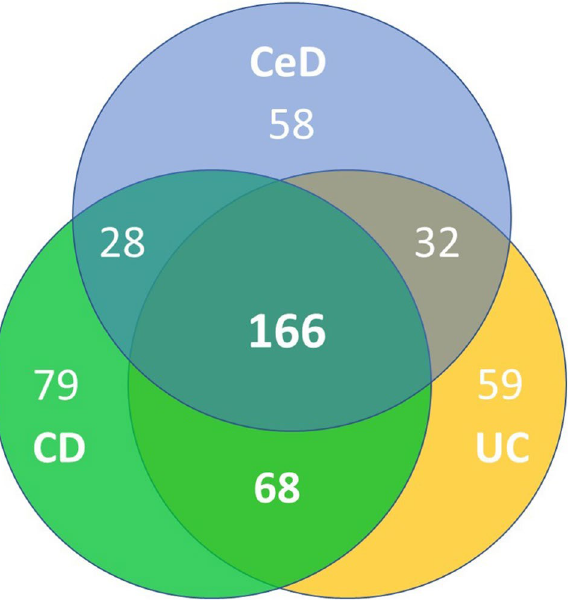
Figure 2. Overview of Phecodes associated with the analysed intestinal disorders. The Venn diagram depicts the numbers of conditions associated with coeliac disease (CeD), Crohn´s disease (CD), and ulcerative colitis (UC). The results are based on the PheWAS analysis comparing the occurrence of all available conditions in individuals with the displayed intestinal disorder versus the reference group without any of these intestinal diseases adjusted for multiple